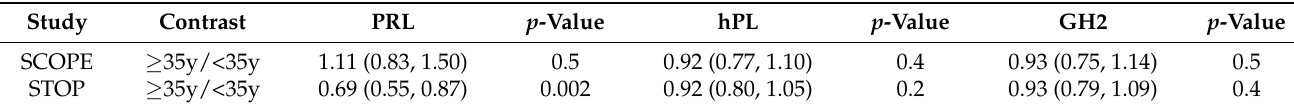
Table 5. Ratio of geometric means (95% CI) for different serum hormone concentrations in SCOPE and STOP stratified by maternal age.